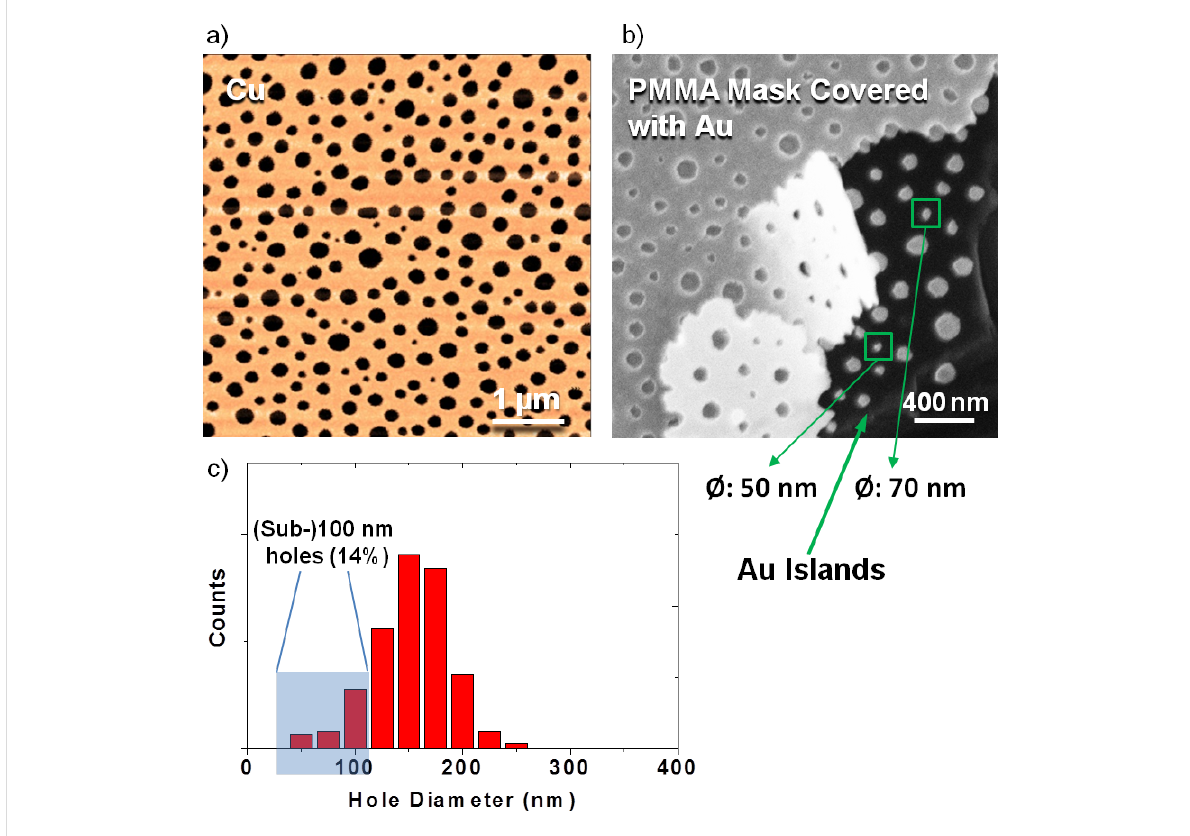
Figure 3: Sub-100 nm holes in a Cu film (left) and gold islands (right) fabricated by metal PBL. a) AFM image of a perforated Cu film with a thickness of 20 nm. b) SEM image of gold islands (with a thickness of 20 nm) with PMMA lithographic mask covered with gold. c) Diameter distribution of the holes in Figure 3a. The holes have an average diameter of about 150 nm and there are holes found in the (sub-)100 nm range (about 14%).